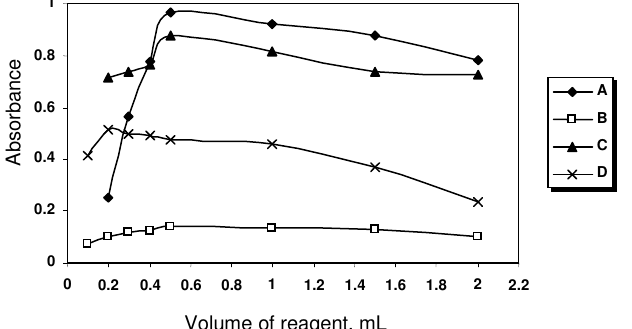
Figure 5. The molar ratio method for the reaction between 1×10 -3 M fast red B salt and (A) 0.5 mL of 1×10 -3 M secnidazole, (B) 0.5 mL of 1×10 -3 M niclosamide (C) 0.5 mL of 1×10 -3 M nifuroxazide and (D)0.2 mL of 1×10 -3 M sulphasalazine.